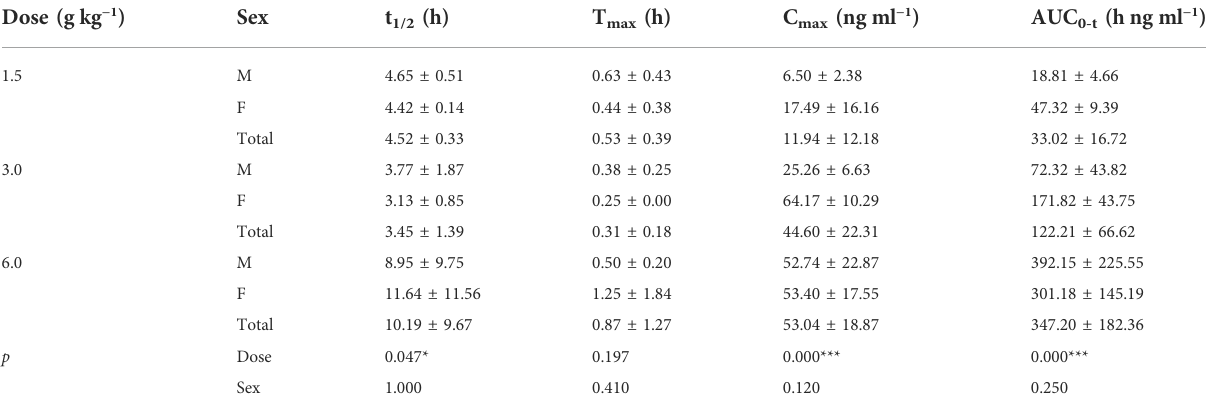
TABLE 7 Pharmacokinetic parameters of piperine after different doses of TYZB in rats (D1). Dose (g kg − 1 ) Sex t 1/2 (h)